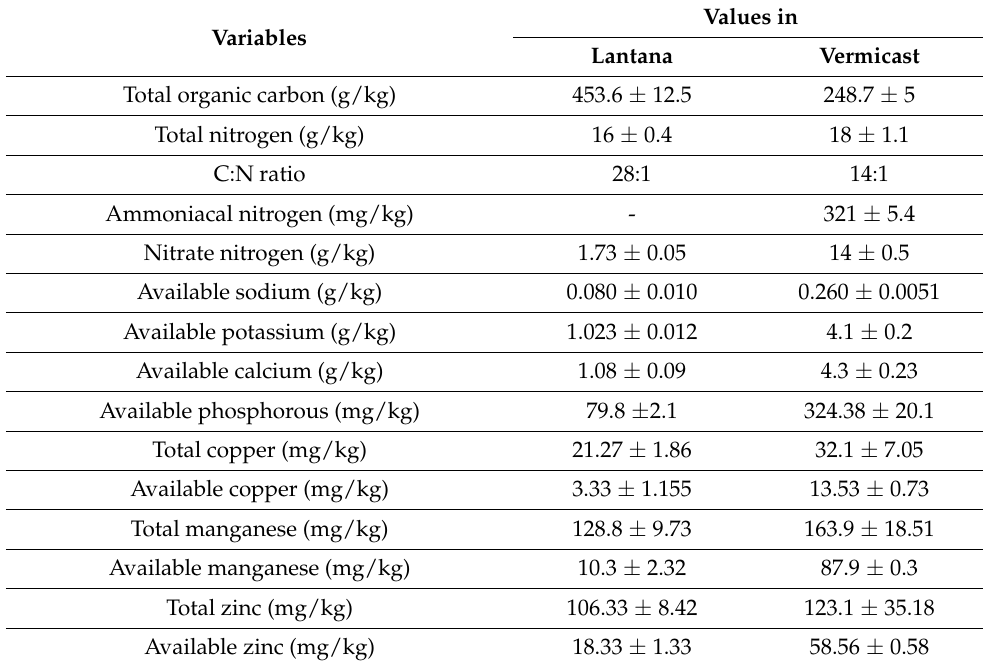
Table 5. Chemical characteristics of lantana and its